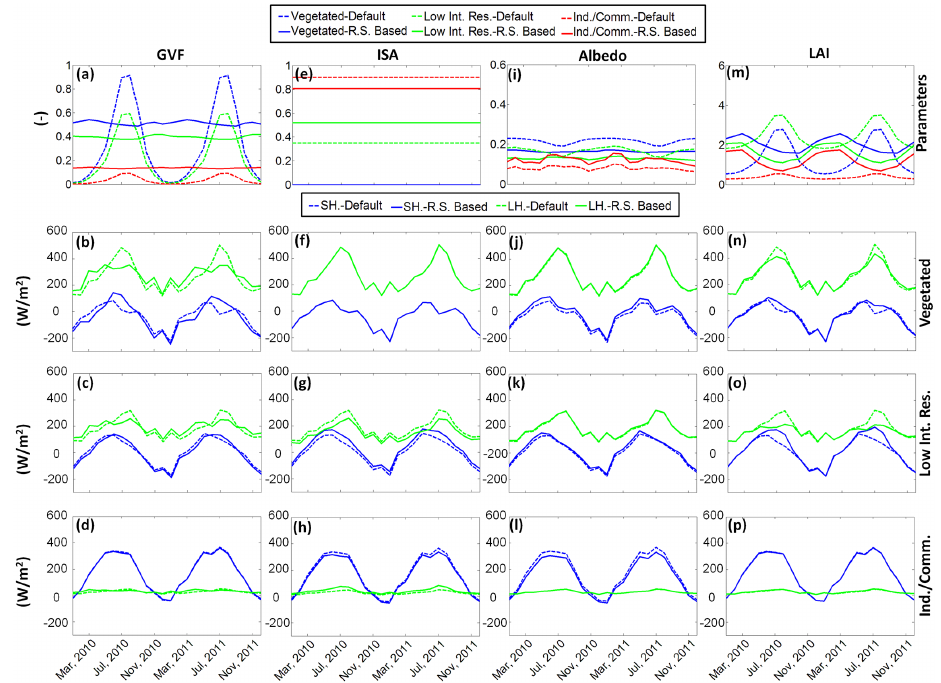
Figure 2. Monthly time series of default Noah UCM compared with remote-sensing-based GVF, ISA, albedo, and LAI (row 1), as well as modeled cumulative monthly sensible and latent heat fluxes (MJm − 2 ) over fully vegetated (row 2), low-intensity residential (row 3), and industrial/commercial areas (row 4) using the default and newly estimated parameters: (b–d) GVF, (f–h) ISA, (j–l) albedo, and (n–p)